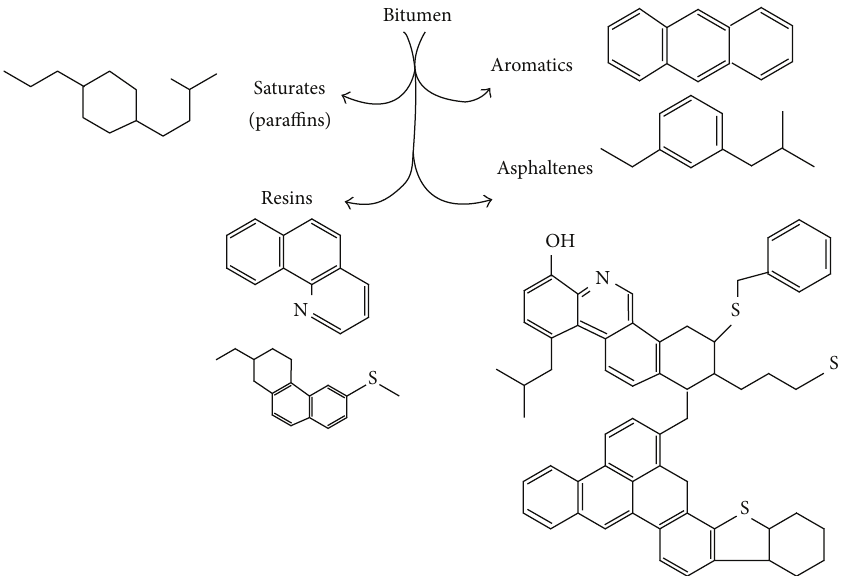
Figure 6: Representative structures of asphalt fractions